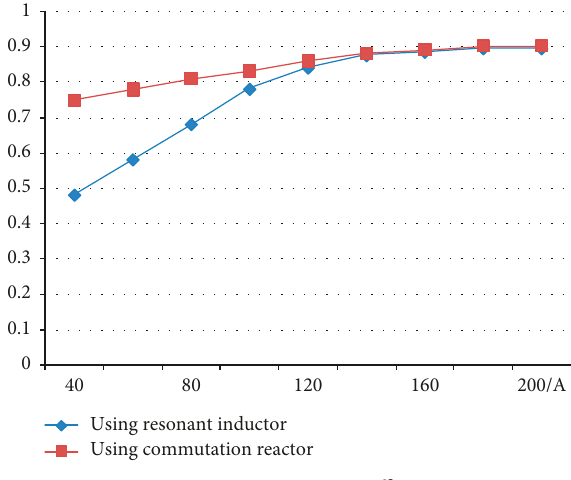
Figure 26: Circuit testing